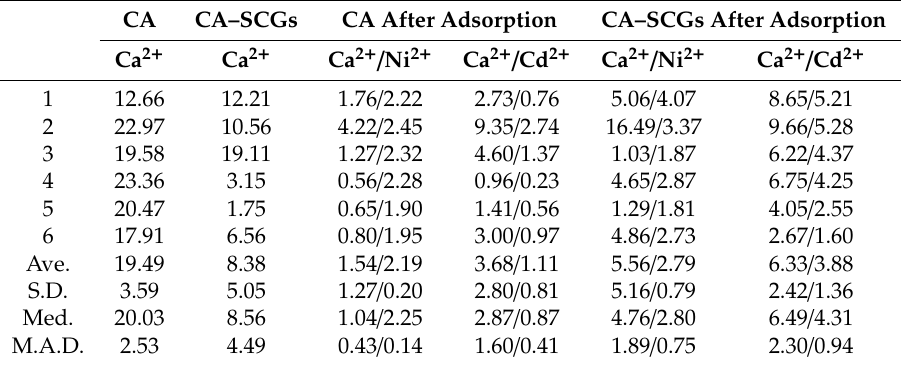
Table 1. Values of wt. % for six